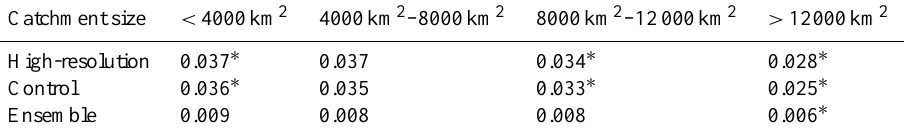
Table 2. Impact of catchment size on FCS BS